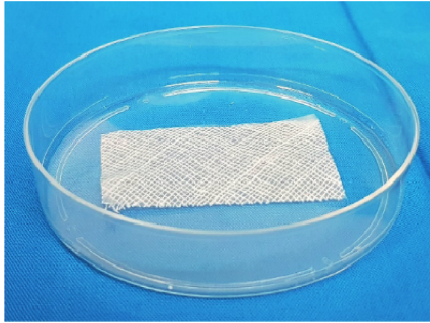
Figure 1: Freeze-Dried Amnion Membrane (FD-AM) in a Petri dish.